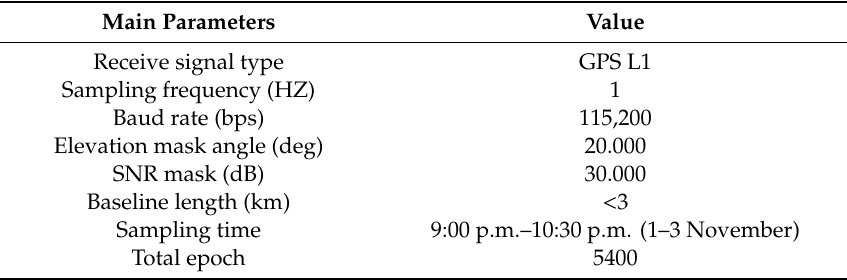
Table 4. The setting of data acquisition parameters.